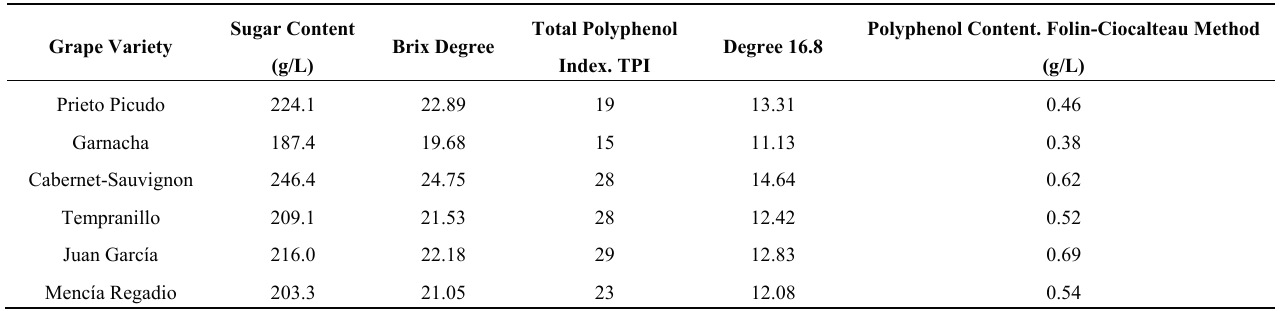
Table 1. Results of the chemical analysis carried out by traditional chemical